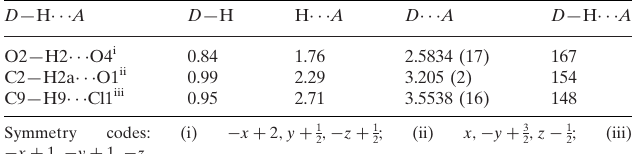
Hydrogen-bond geometry (A˚ , (cid:2)